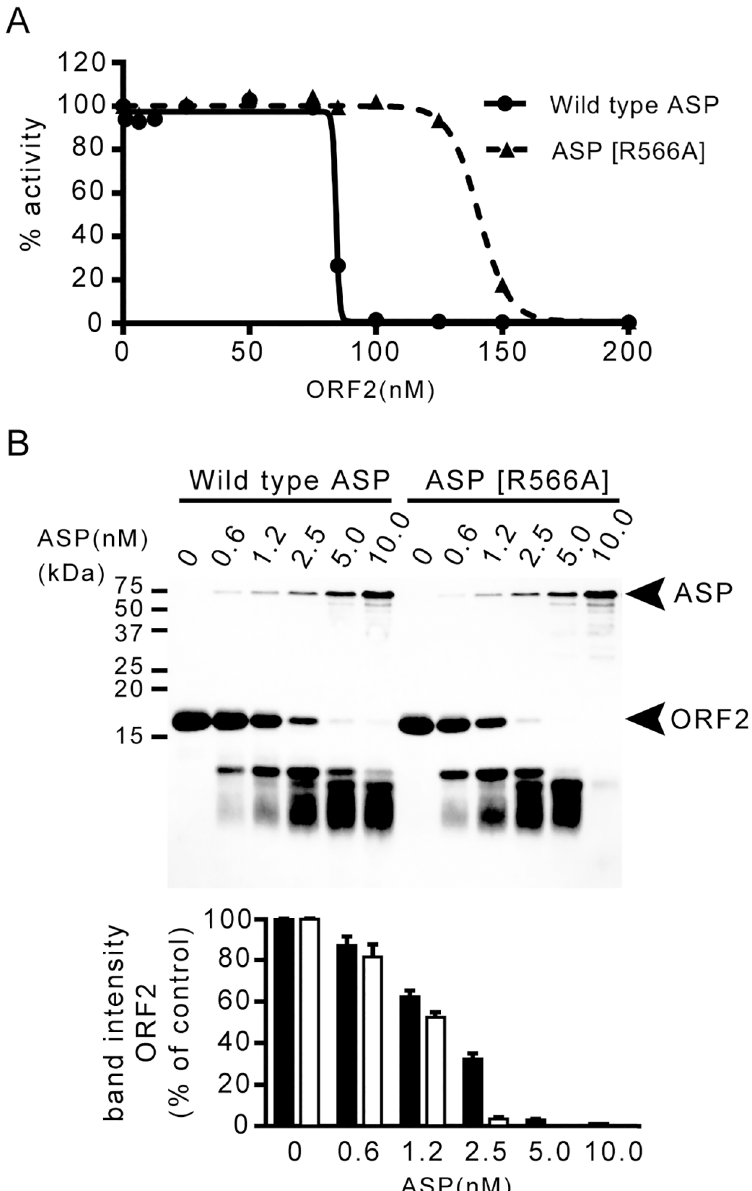
Fig 4. The inhibitory action of ORF2 against ASP or ASP[R566A] and the degradation of ORF2 by ASP or ASP[R566A] in the reaction mixture. (A) Determination of the IC 50 for ORF2 againstASP or ASP [R566A]. ASP or ASP[R566A] activity against the synthetic substrate, Boc-Glu-Lys-Lys-MCA in the absence of ORF2 is definedas 100% activity. (B) Degradation of ORF2 by ASP or ASP [R566A]. A purifiedORF2 preparation (60 μ M) was incubatedwith various concentrations (0–10 nM) of ASP or ASP [R566A] solutions. The locations of intact ORF2 and ASP or ASP[R566A] are indicatedby the arrows (upper panel). The band intensity of ORF2 incubatedwith ASP (black bar) or ASP[R566A] (white bar) was also shownin lower panel. The IC values for ASP and ASP[R566A] were calculated as 84.3 nM and 140.6 nM, respec- 50 tively. This result indicates that the inhibitory effect of ORF2 against ASP was decreased by the point mutation of the Arg-566 residue of ASP. We therefore suspect that the Arg-566 residue of ASP is also engaged in the interaction with ORF2.